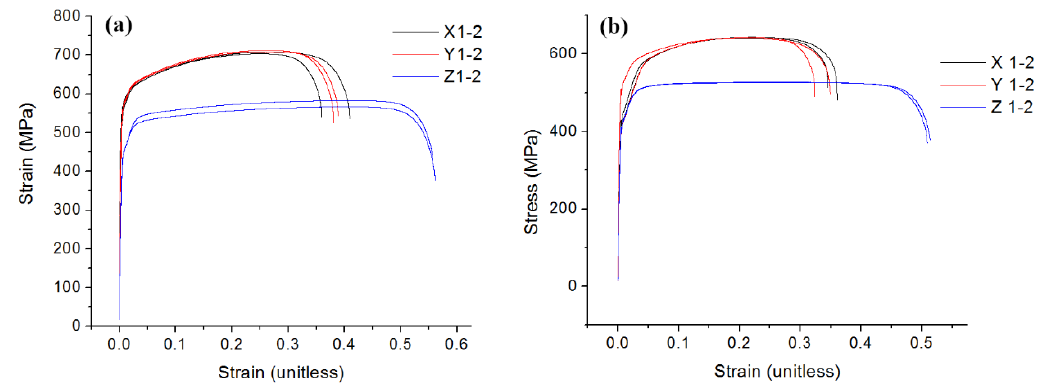
Figure 12. Stress–strain curves for the tensile samples produced via L-PBF using ( a ) Powder A and ( b ) Powder B, as feedstocks.